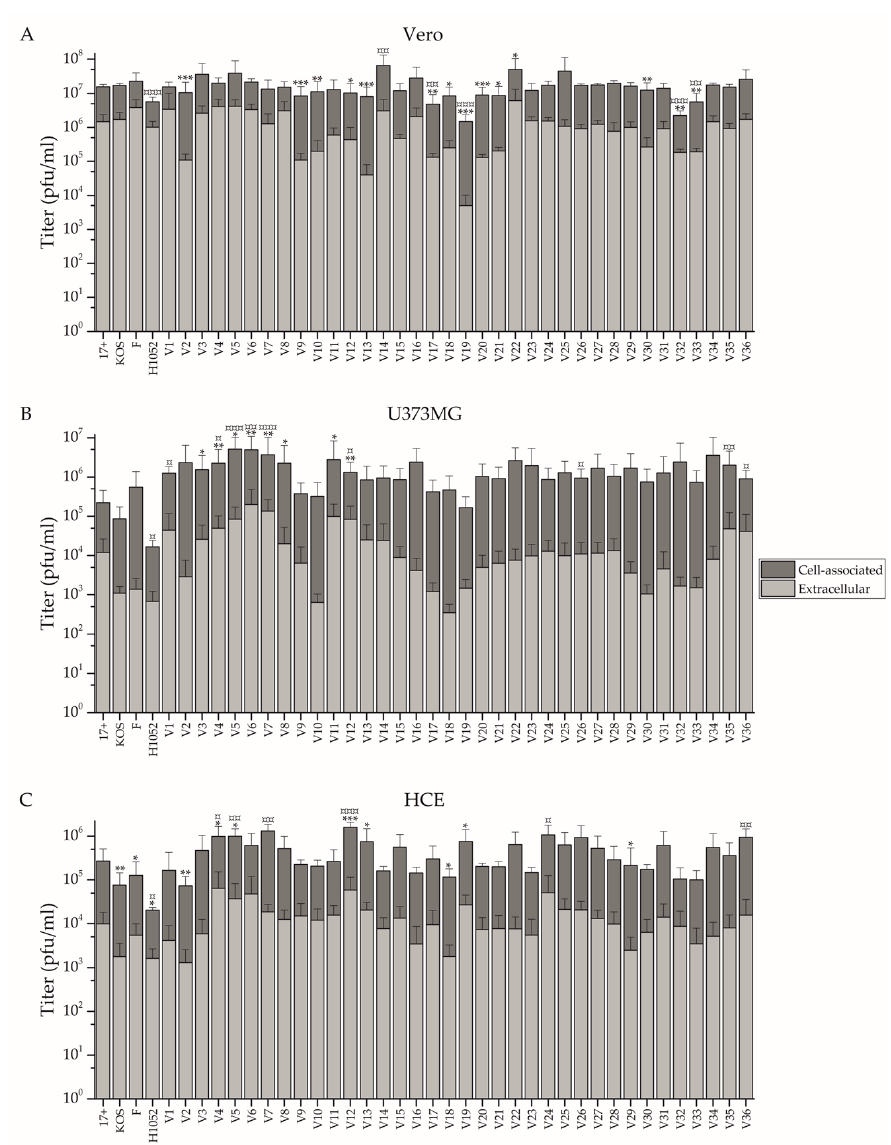
Figure 2. The replication profiles of the clinical isolates, based on extracellularly released progeny and cell-associated virus. The light gray bars depict the extracellular titer and the dark gray bars the cell-associated titer. The bars are shown overlaid on each other to emphasize how cell-associated titers are consistently higher than extracellular titers. ( A ) Vero, ( B ) U373MG, and ( C ) HCE cells were infected with 0.1 pfu/cell of each clinical isolate. At 24 h post infection (hpi), samples of extracellular virus shed to the supernatant, and cell-associated virus bound in the cells were taken separately from each sample. The extracellular and cell-associated titers were then determined with a plaque assay. The bars represent the titers in pfu/mL. The whiskers represent the standard deviation of the mean ( N ≥ 8 per clinical isolate, data from two individual experiments). The reference virus 17+ was used for pairwise comparisons separately for extracellular (*, p < 0.05; **, p < 0.01; ***, p < 0.001) and cell-associated virus (¤, p < 0.05; ¤¤, p < 0.01; ¤¤¤, p < 0.001)